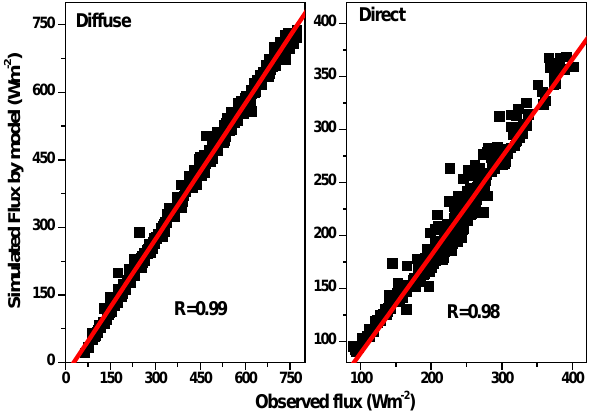
Fig. 6. Scattergrams of the observed and calculated solar irradiance at the surface after adjusting SSA and ASY.